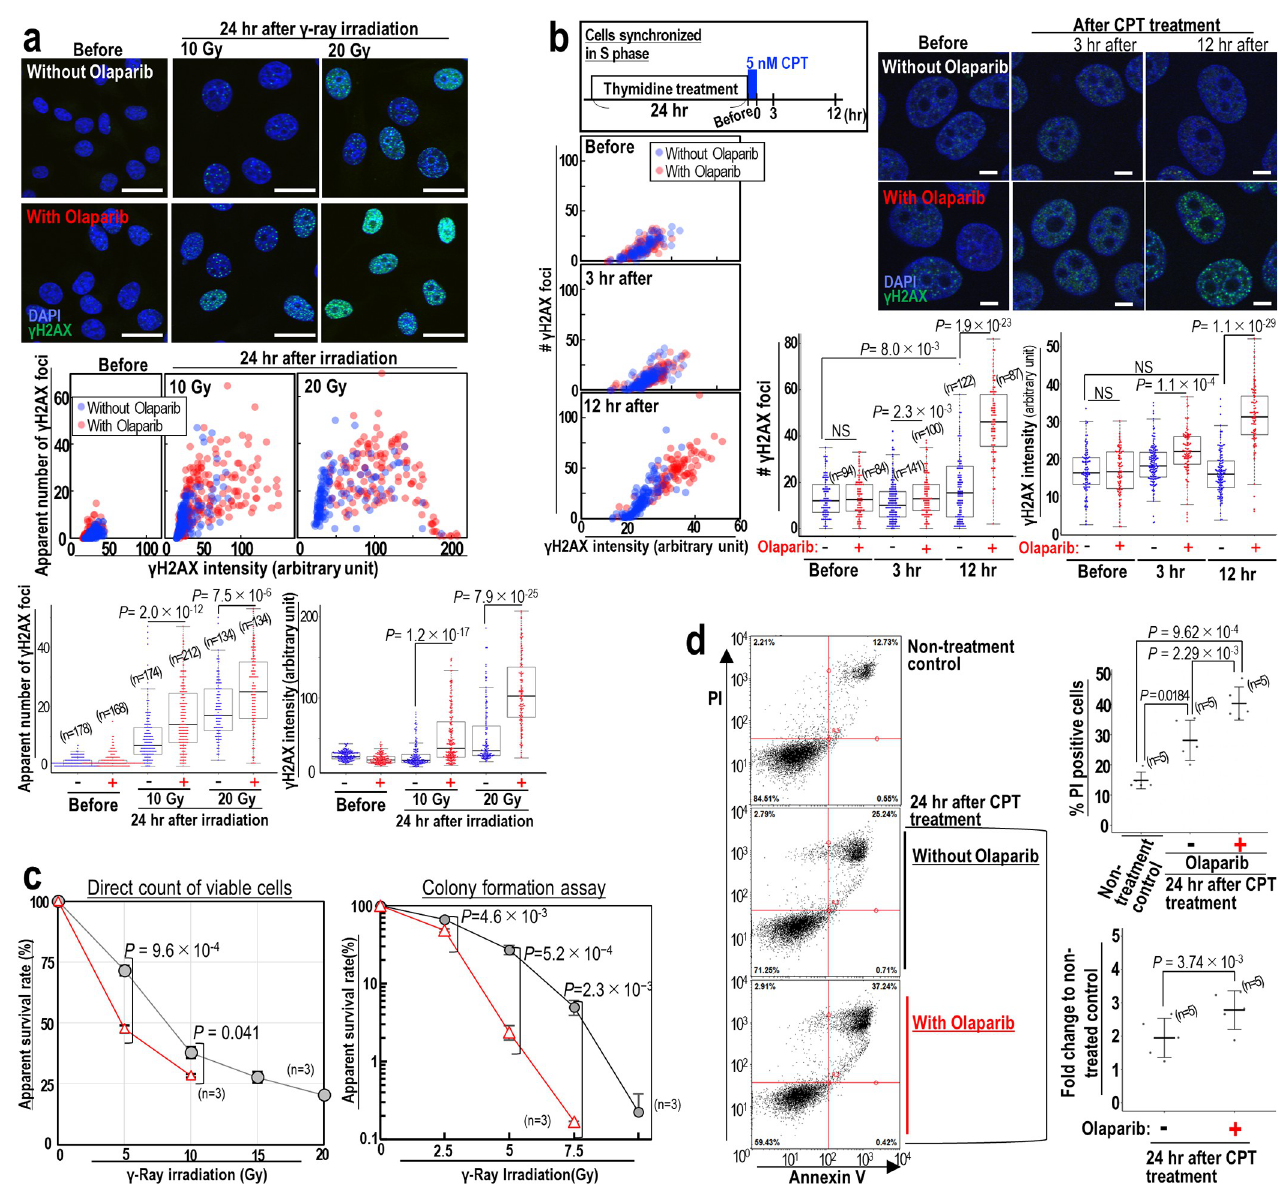
Fig 5. Sensitized DSB responses in the presence of Olaparib. ( a ) MCF7 cells were irradiated with 10 and 20 Gy γ -ray, and cultivated for 24 hr. γ H2AX intensity and number of γ H2AX foci are plotted together and separately in the absence (blue dots) and the presence (red dots) of Olaparib. Scale bars in images, 30 μ m. Bars show means ± s.d. Two-tailed Welch’s t-test was used for statistical analysis. ( b ) MCF7 cells synchronized in S phase were pulse treated with CPT for 1 hr and further cultivated for 12 hr, as described in the upper panel. γ H2AX intensity and number of γ H2AX foci are plotted together and separately in the absence (blue dots) and presence (red dots) of Olaparib. Scale bars in images, 10 μ m. Bars show means ± s.d. Two-tailed Welch’s t-test was used for statistical analysis. ( c ) Cell survival calculated by direct counting of surviving cells 5 days post γ -ray irradiation in the presence or absence of Olaparib (red triangle and black circles, respectively). The numbers of surviving cells irradiated with 15 and 20 Gy in the presence of Olaparib were too low and therefore could not be counted. Cell survival was similarly estimated by colony formation assay. Bars show means ± s.d. Two-tailed Welch’s t-test was used for statistical analysis. ( d ) MCF7 cells treated as in ( b ) in the presence and absence of Olaparib. Cell death was analyzed by double staining of PI and annexin V (n numbers are indicated on graph). Bars show means ± s.d. Two-tailed Welch’s t-test was used for statistical analysis.